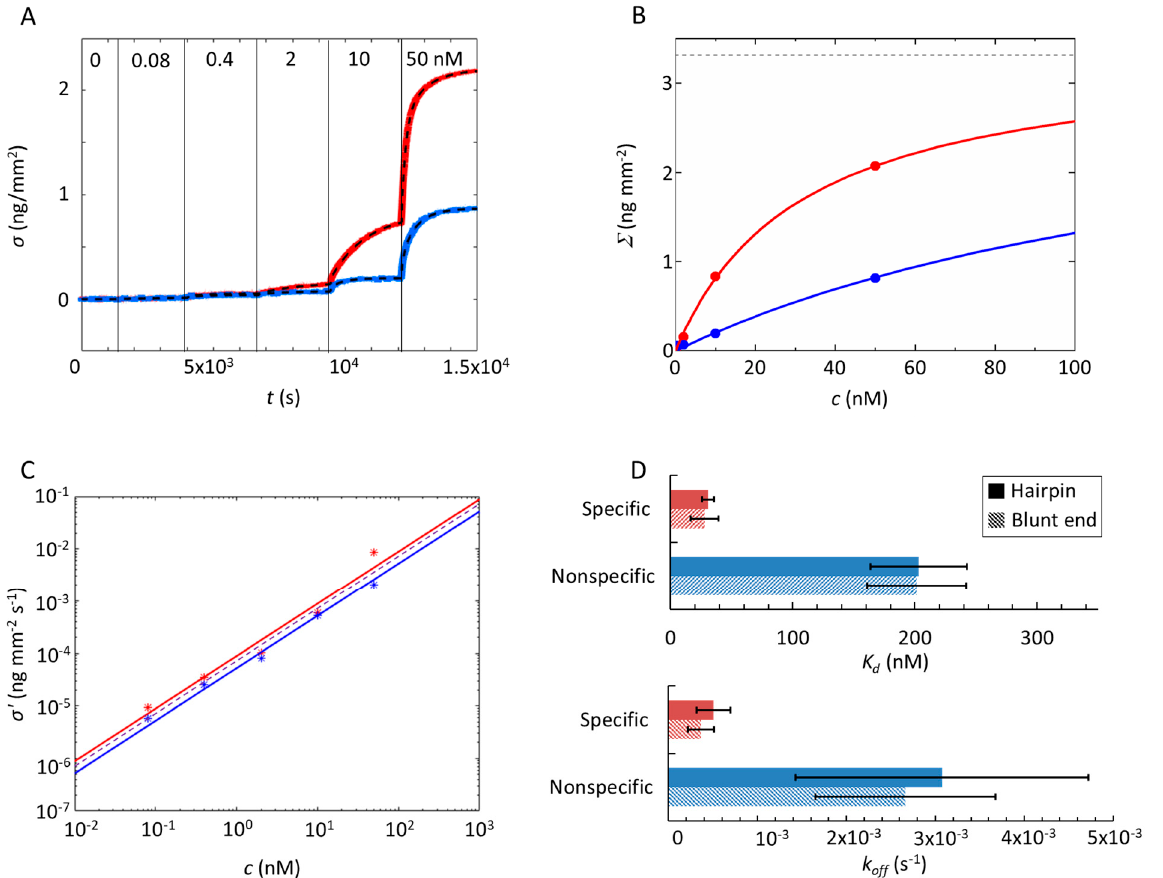
Figure 2. Analysis of the Gal4–DNA interaction. ( A ) Increase of the surface density ( σ ) measured over time upon protein binding to specific (red) and nonspecific (blue) sequences for increasing the concentration of Gal4 in a solution (ionic strength I s = 150 mM, T = 30 °C and c = 10 μ M). At the time indicated by the vertical lines, the Gal4 concentration was increased stepwise from 0 to 50 nM, as reported in the figure. The dashed curve superimposed to the data represents the fitting with exponential growth functions (Equation (1)), from which the rate Γ ( c ) and the amplitude Σ ( c ) of the binding curves are extracted. ( B ) The amplitude Σ (c) for specific and nonspecific probes (same colors as in panel A) upon an increase of protein concentration. Lines are fits with the Langmuir model Equation (2). The dashed horizontal line represents the asymptotic value for Σ ( c → ∞ ) obtained from the fit. ( C ) Initial slope σ ’( c ) of the exponential fit shown in (A) for specific and nonspecific probes. Continuous and dashed lines are separate and common fits to the data, respectively, as discussed in the text. ( D ) Bar graph showing the equilibrium dissociation constant ( K d ) (upper) and k off (lower) of Gal4 on double ‐ stranded DNA (dsDNA) (with hairpin or blunt ends) for specific and nonspecific sequences. The error bars represent the SD computed from three independent experiments.